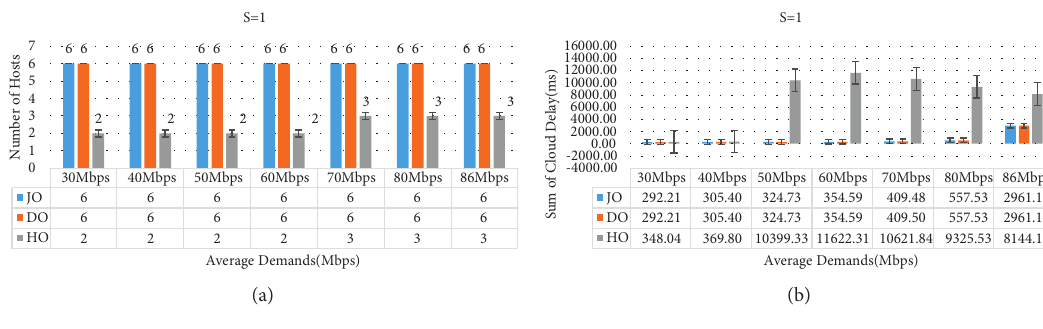
Figure 4: Global comparison for each algorithm when S � 1.